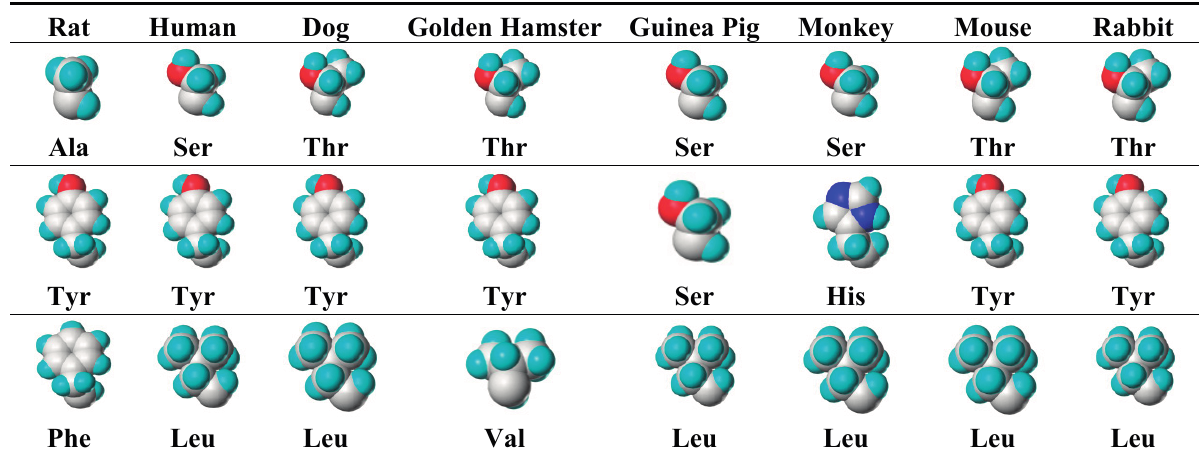
Table 1. Structures of the amino acid residues in the substrate-binding pocket in mammalian CYP1A1s.